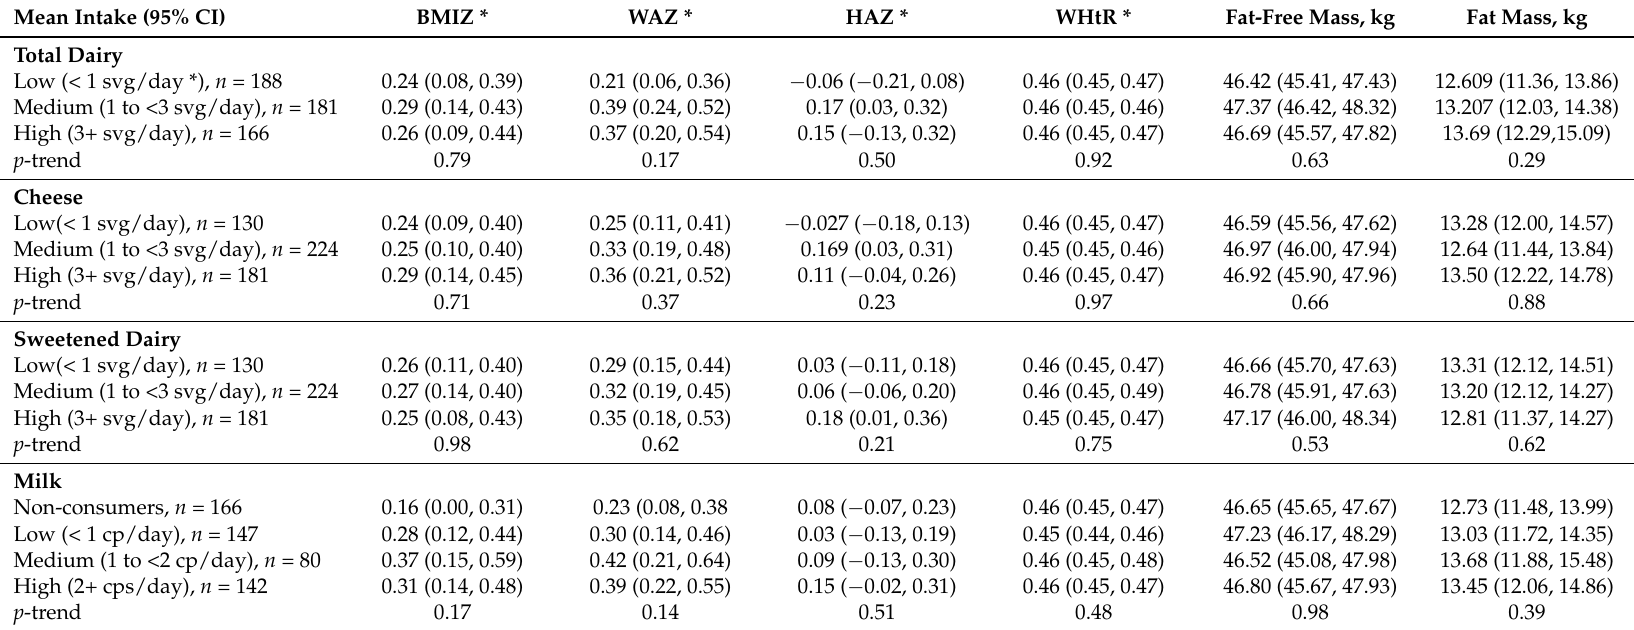
Table 2. Mean (95% CI) of growth and health indicators according to levels of dairy foods intake, all